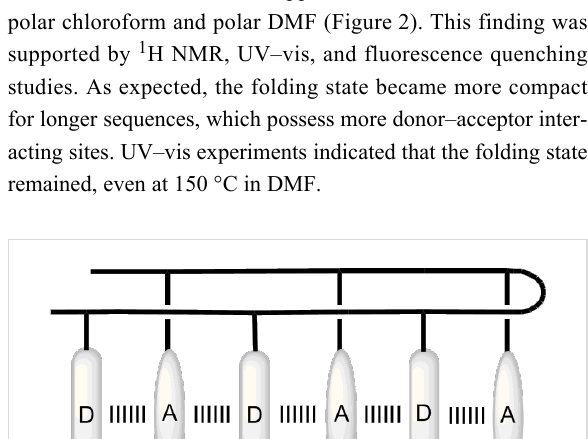
Encouraged by the above work, Junli Hou, who is currently a professor at Fudan University, prepared naphthalene-incorpo- rated oligo(ethylene glycols) 12a–g [25] (Scheme 6).